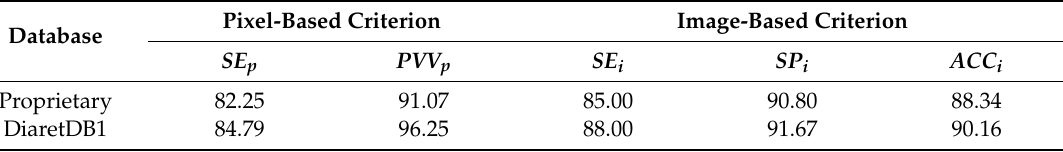
Table 2. Results for the detection of red